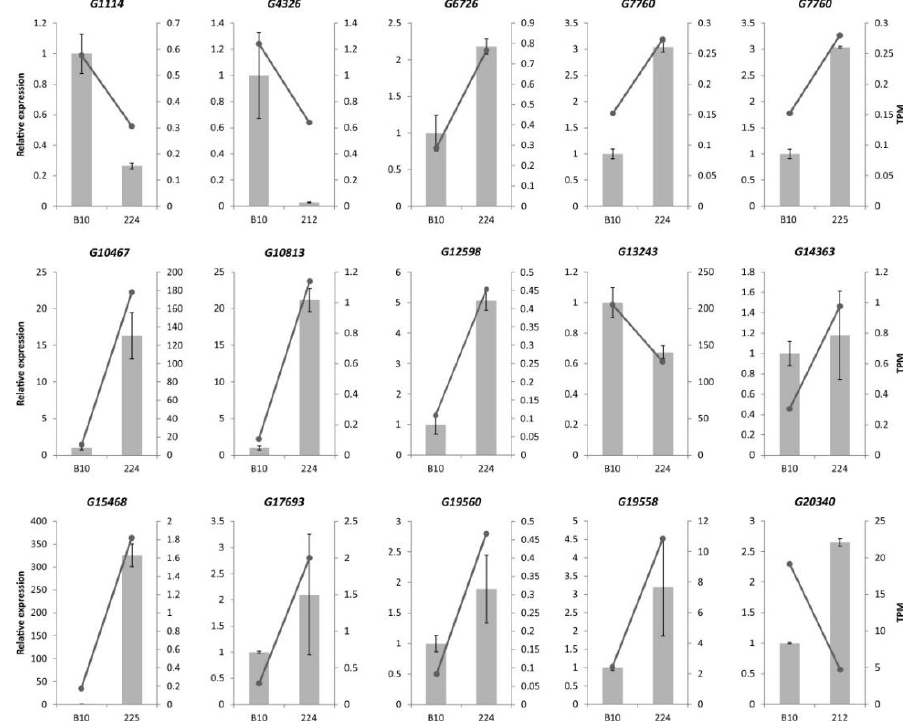
Figure 3. Validation of differentially expressed genes (DEGs) by qPCR. The qPCR results are presented (with grey bars) as relative expression levels. The RNA-seq data (black line) are presented in transcripts per million (TPM).